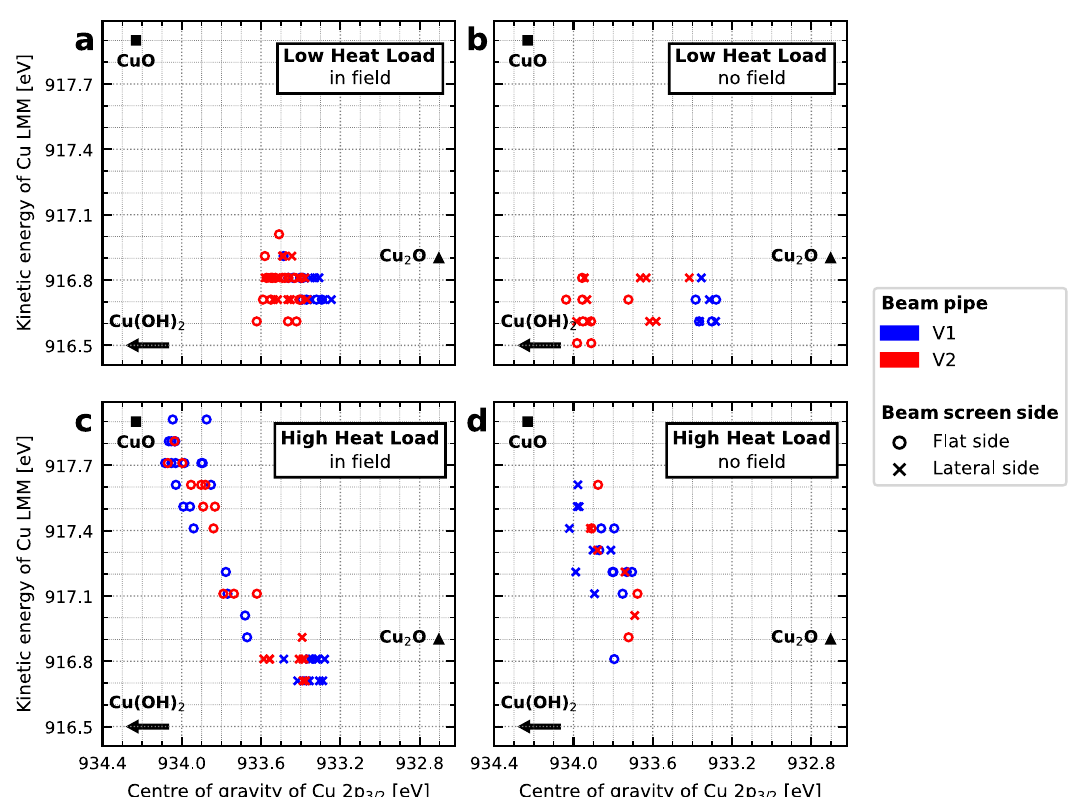
Fig. 6 Systematic identi fi cation of copper oxidation products. Wagner-like plots, considering the position of the Cu 2p 3/2 peak centre of gravity instead of intensity maximum, for all X-ray photoelectron spectroscopy (XPS) spectra acquired on the beam screens from a , b Low Heat Load and c , d High Heat Load LHC dipoles, a − c in fi eld and b − d fi eld-free regions. The data points corresponding to V1 beam screens are represented in blue, while the ones of V2 beam screens are plotted in red. Data acquired on the fl at sides of the beam screens are represented by circles and crosses are used for data acquired on the lateral beam screen sides. The data points for reference spectra (pure compounds) are shown in black for